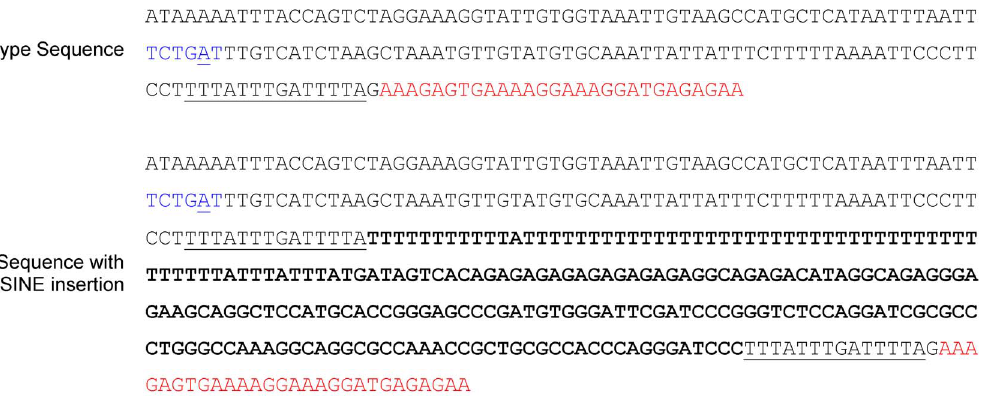
Figure 7. FAM161A c.1758-15_1758-16ins238 effect on pre-mRNA splicing. Wildtype and FAM161A 2 / 2 sequence, with exon 5 (red), intron 4 (grey) and SINE insertion c.1758-15_1758-16ins238 (black) indicated. In the wildtype sequence, the putative BPS (blue, with the critical A underlined) is 76 bp upstream of the intron-exon boundary, while in the affected sequence it is . 300 bp upstream of the boundary.